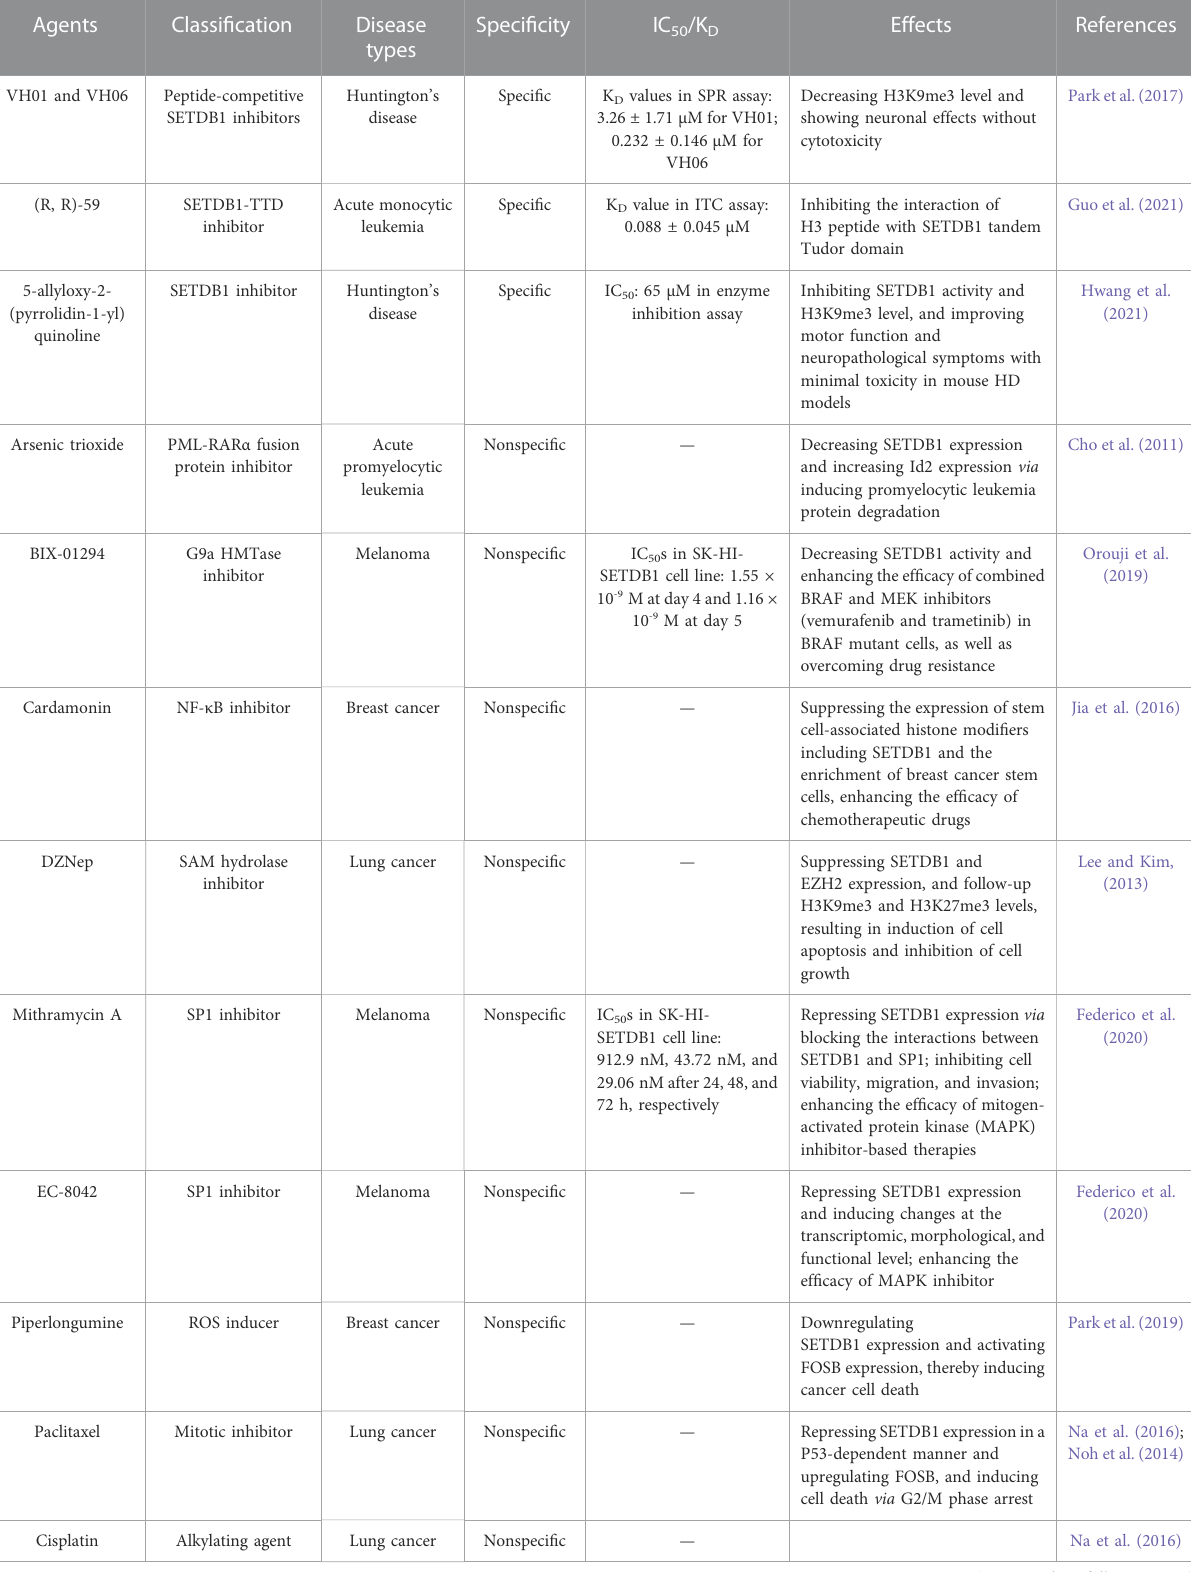
TABLE 1 List of the reported small molecule SETDB1